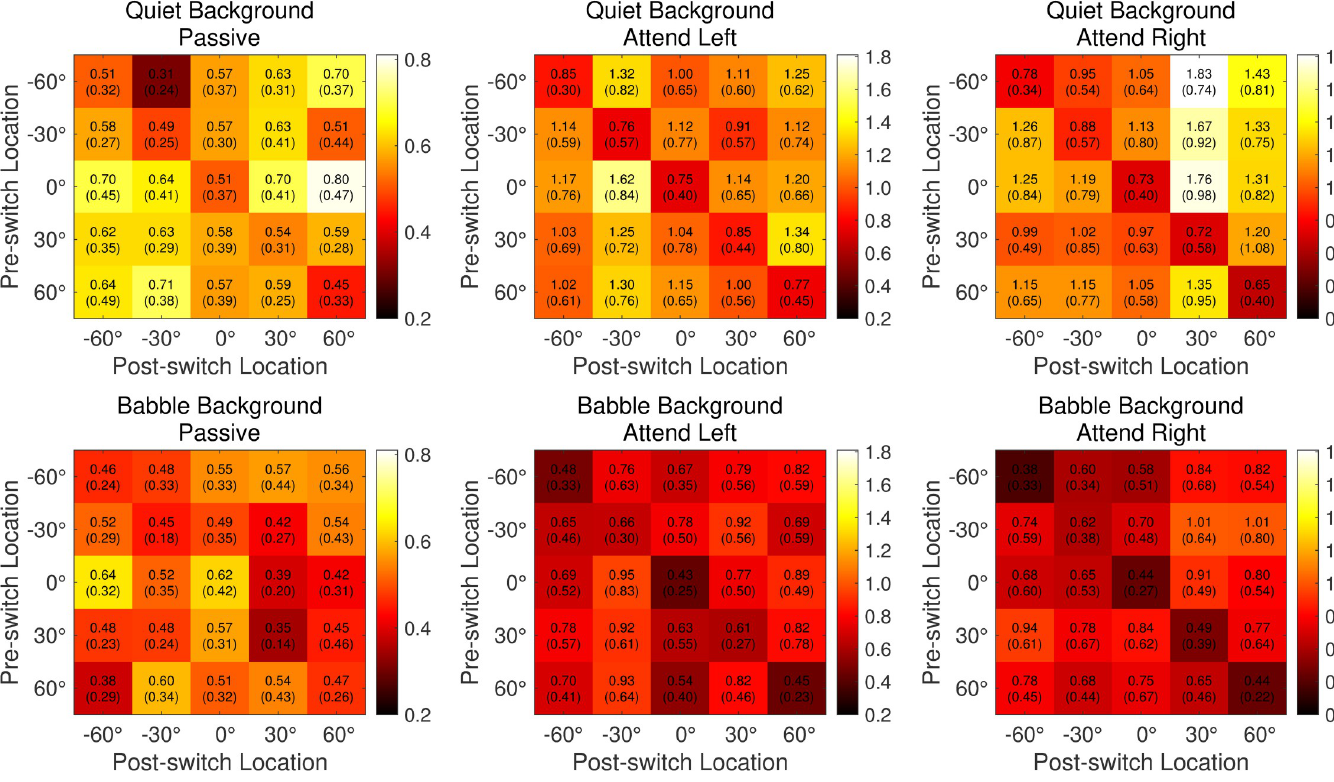
Fig 6. Results per attention and background condition are reported as matrices of GFP activity at around 550 ms with rows indicating the pre-switch location and columns indicating the post-switch location. Matrix cells along the diagonal from top left to bottom right represent catch trials in which stimuli had no location change. Panels on the left are for Passive conditions and have a different range of values compared to the two attention conditions (middle: Attend Left; right: Attend Right) as indicated by the color bars. The top panels are for quiet conditions and the bottom panels are for the babble conditions.